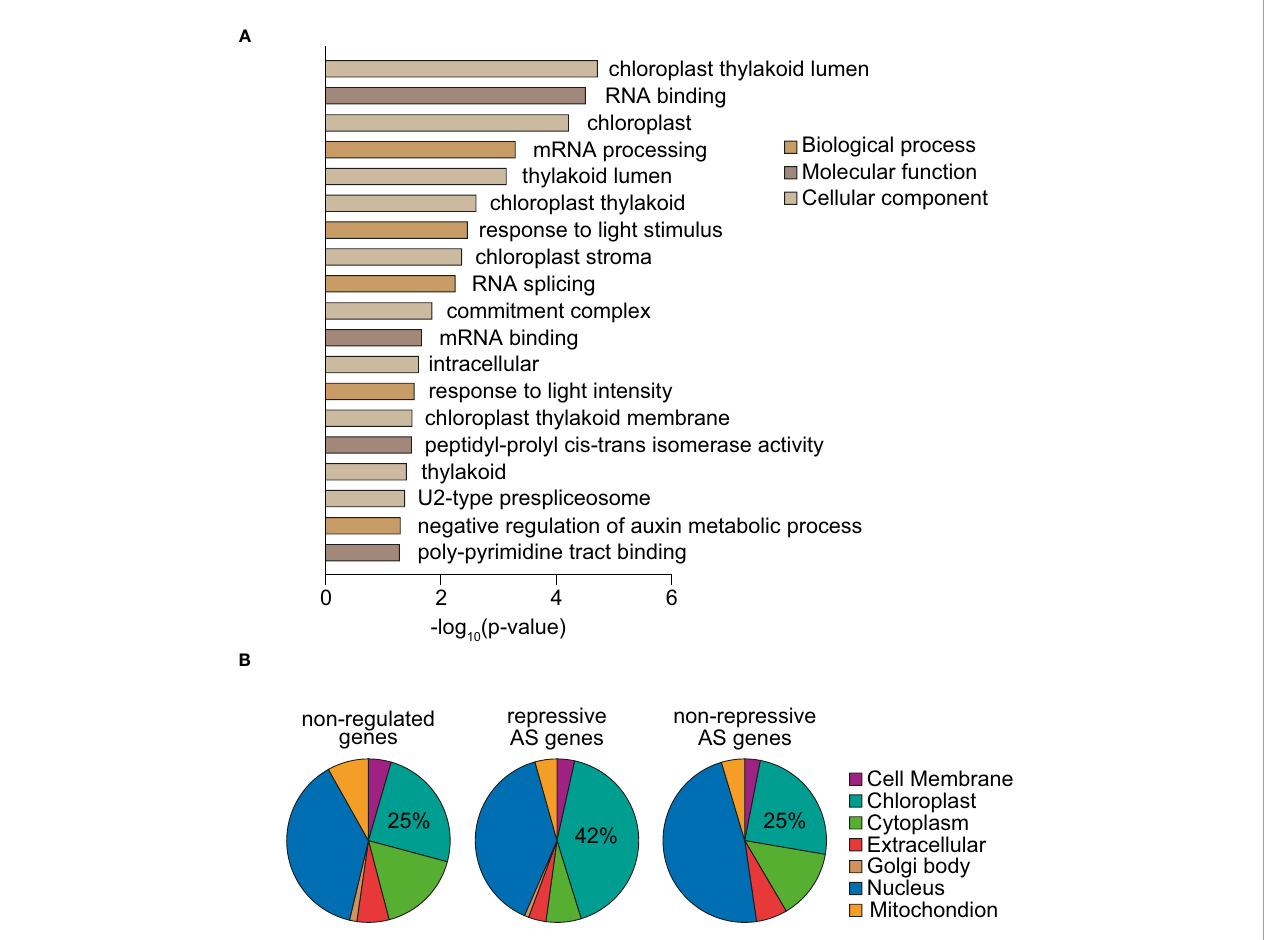
FIGURE 5 Functional analysis of genes differentially spliced in response to nor fl urazon. (A) Enriched gene ontology categories of the 205 genes de fi ned as differentially spliced in response to nor fl urazon. DAVID p-value indicates signi fi cance (Fisher ’ s exact test; P < 0.05). (B) Subcellular localization of genes non-regulated by AS in response to nor fl urazon (non-regulated) and harboring repressive AS events or other types of RS-regulated AS events (non- repressive). The subcellular classi fi cation is based on the Araport 11 predictions available at TAIR (http://www.arabidopsis.org). The percentage of genes encoding for chloroplast-located proteins for each set is